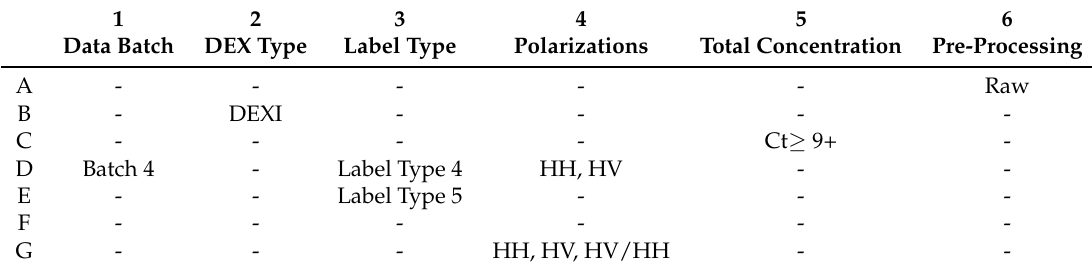
Table 2. Dataset configuration naming